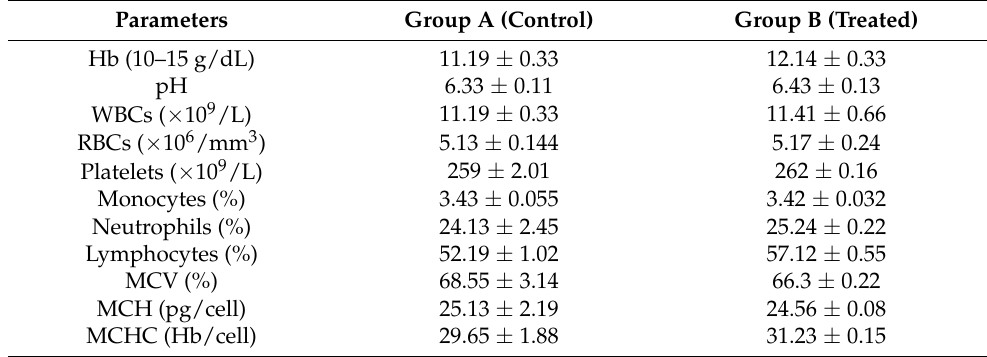
Table 6. Results of biochemical analysis of rabbit’s